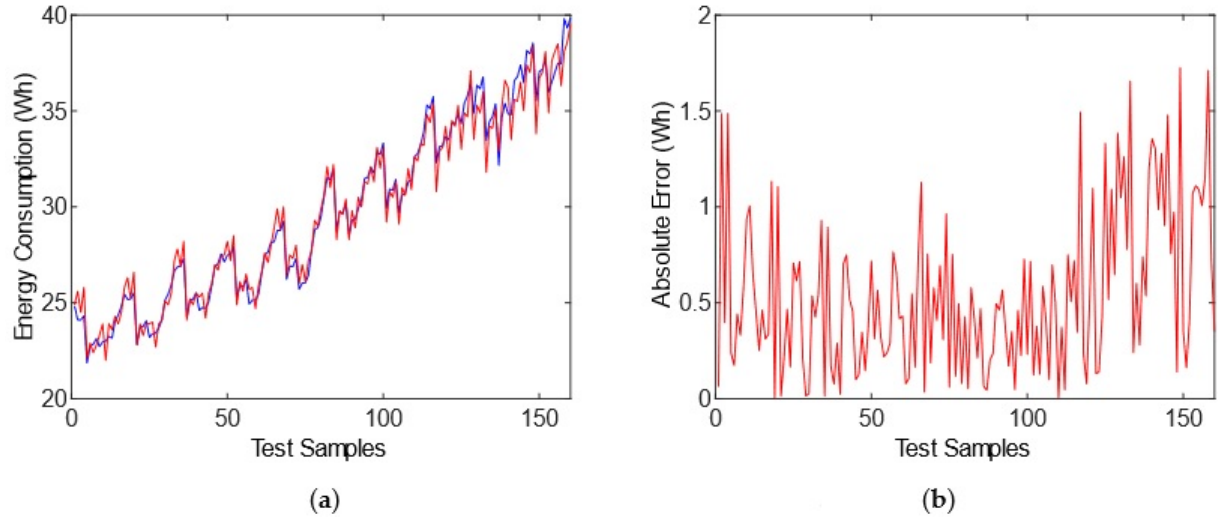
Figure 7. FNNs model results in Test 2. ( a ) Data estimated (red) versus energy consumption data measured (blue). ( b ) Absolute error between estimated behavior and measured energy consumption (red).